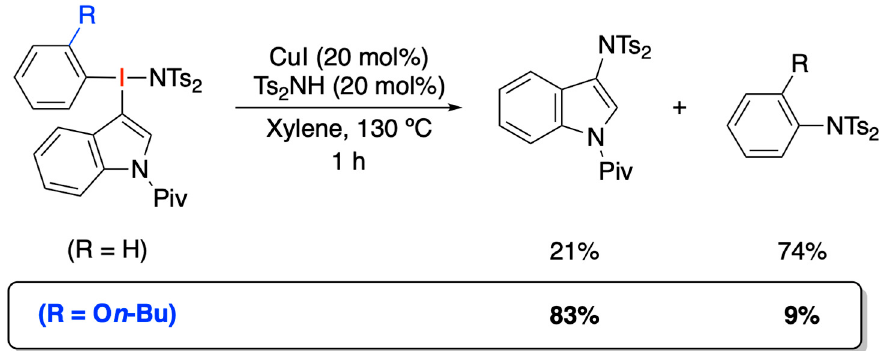
Table 1. Screening for ArI(OAc) 2 and solvent for 3-amination of indole ( 1a